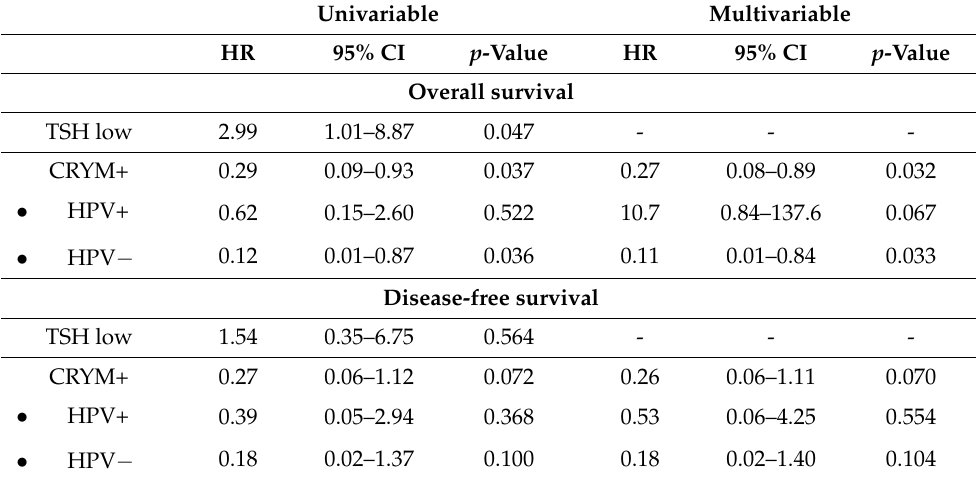
Table 2. Uni- and multivariable time-to-event analysis for OS and DFS. Univariable Multivariable HR 95% CI p -Value